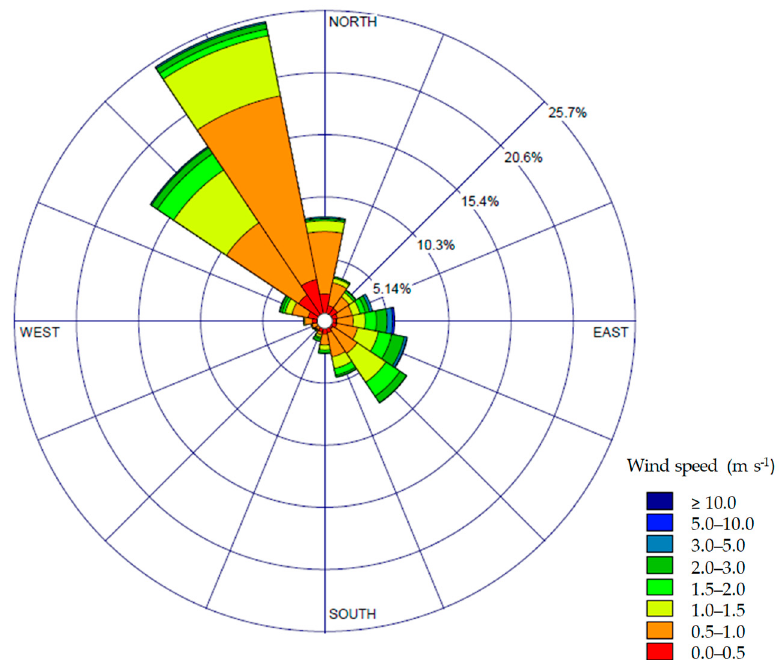
Figure 2. Ground-level (10 m) wind rose at the plant location for the simulation reference period (1 May 2018–30 April 2019).